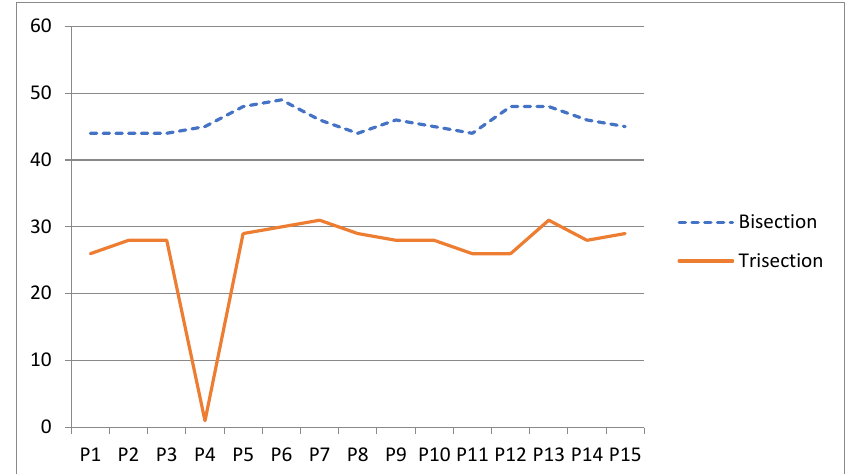
Figure 2. A comparison among 7 methods on 15 problems according to the number of iteration.